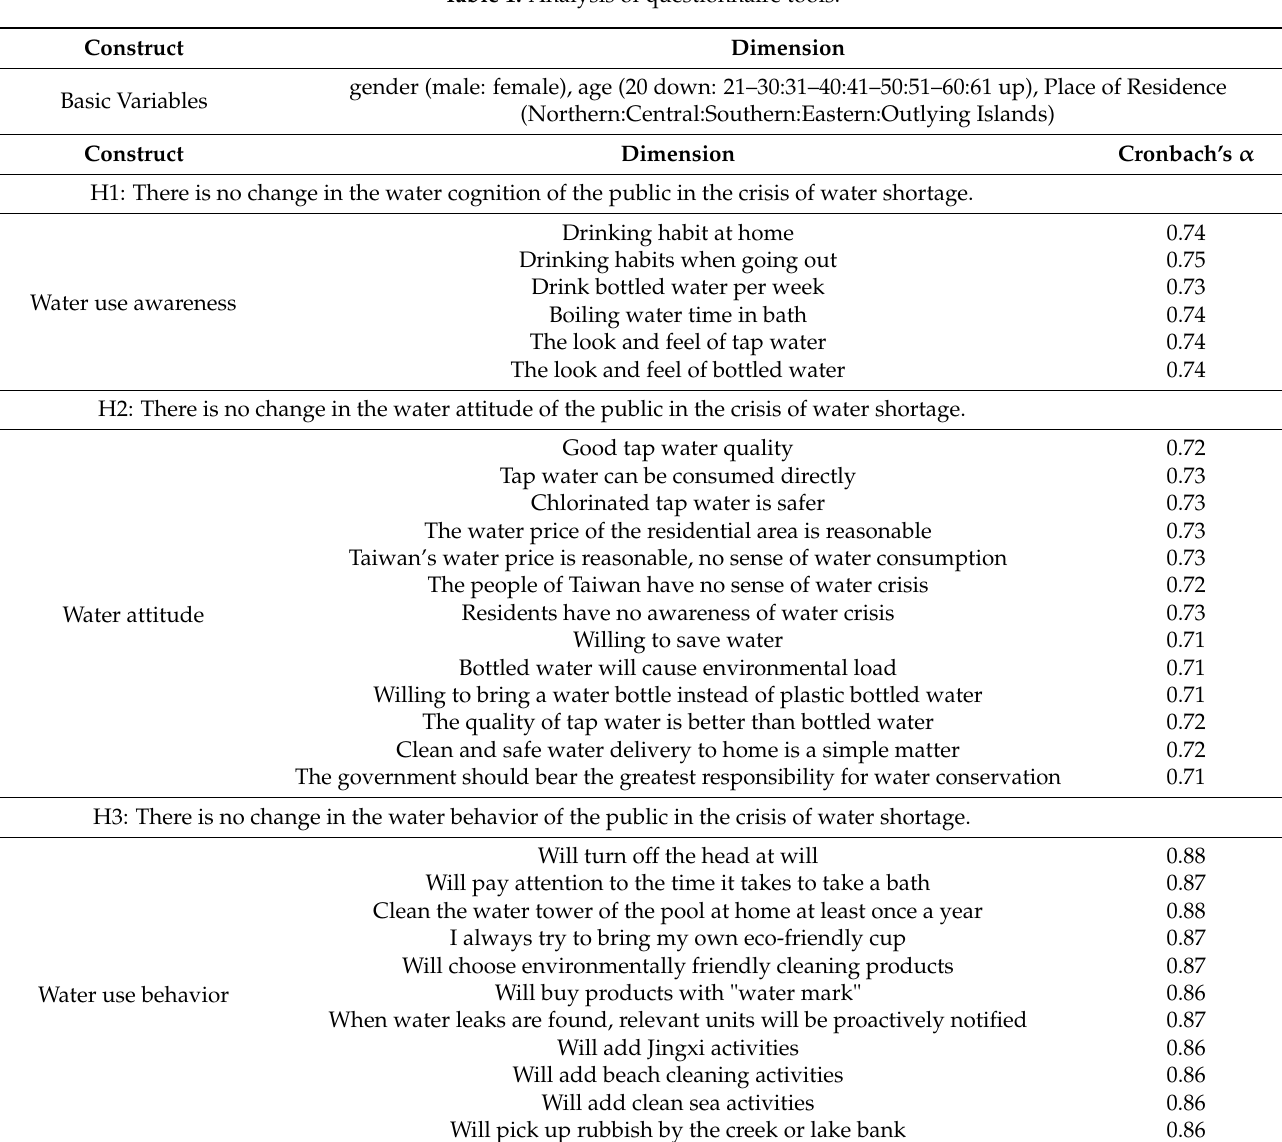
Table 1. Analysis of questionnaire